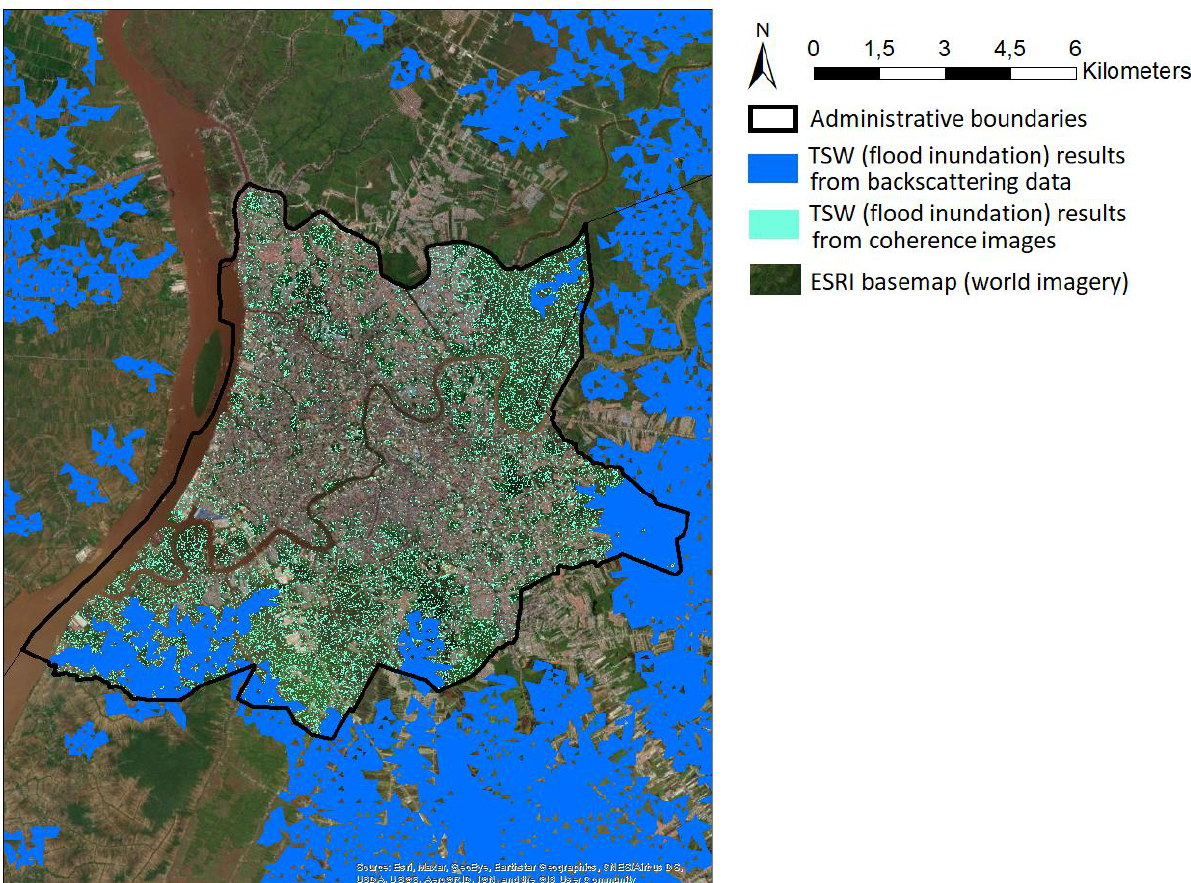
Figure 6 . Temporary Surface Water (TSW) Result from Backscattering Data and Coherence